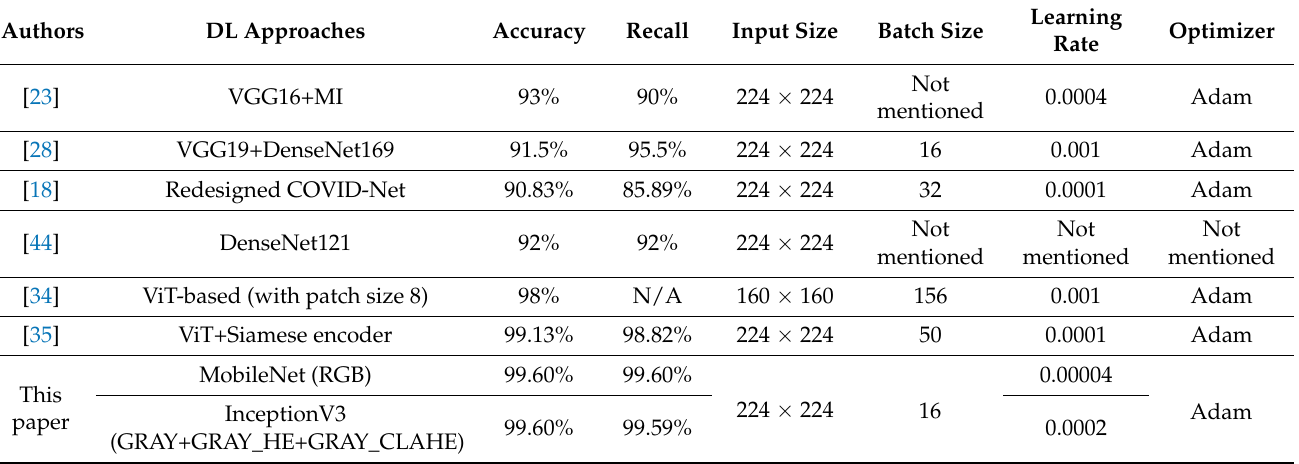
Table 10. Comparisons with the state-of-the-art studies that used the SARS-CoV-2 dataset.